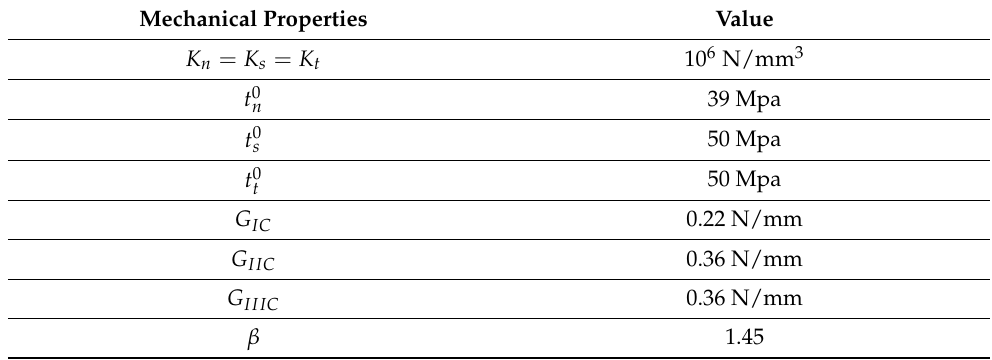
Table 4. Material properties of the cohesive interface.